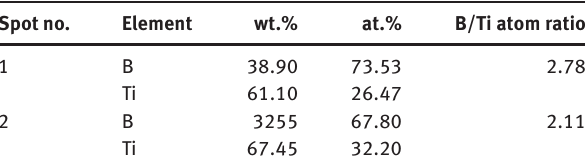
Figure 6: Hardness of TiB power (70 mTorr, TiCl